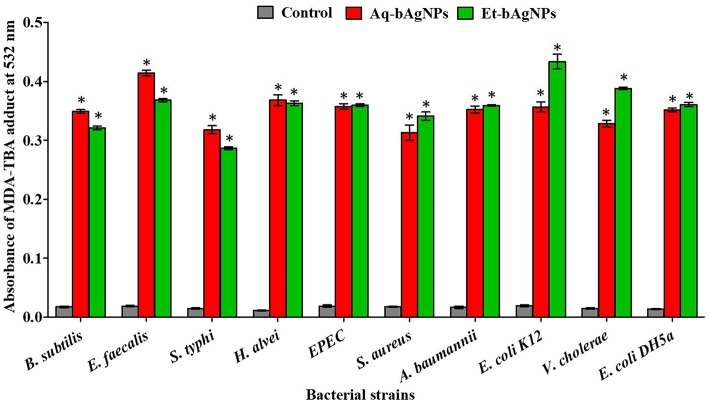
Lipid peroxidation assay. The cell membrane fatty acid oxidation potential of biogenic silver nanoparticles was measured through MDA–TBA adduct assay. The absorbance of MDA–TBA pink adduct was measured at 532 nm (i.e., λmax). The values presented are mean ± SE of multiple samples (n = 3). Data were analyzed using one-way ANOVA followed by Tukey's multiple comparison test. The absorbance of MDA–TBA adduct of bAgNPs treated bacteria were significantly higher than that of the untreated bacteria (i.e., control) and *P < 0.01.